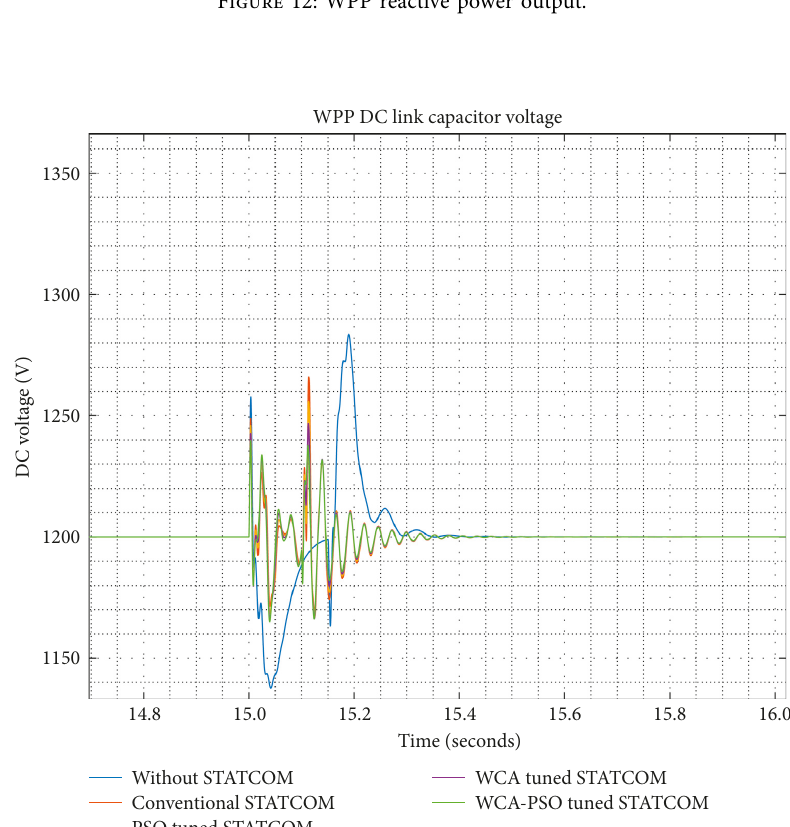
Figure 13: DC link capacitor